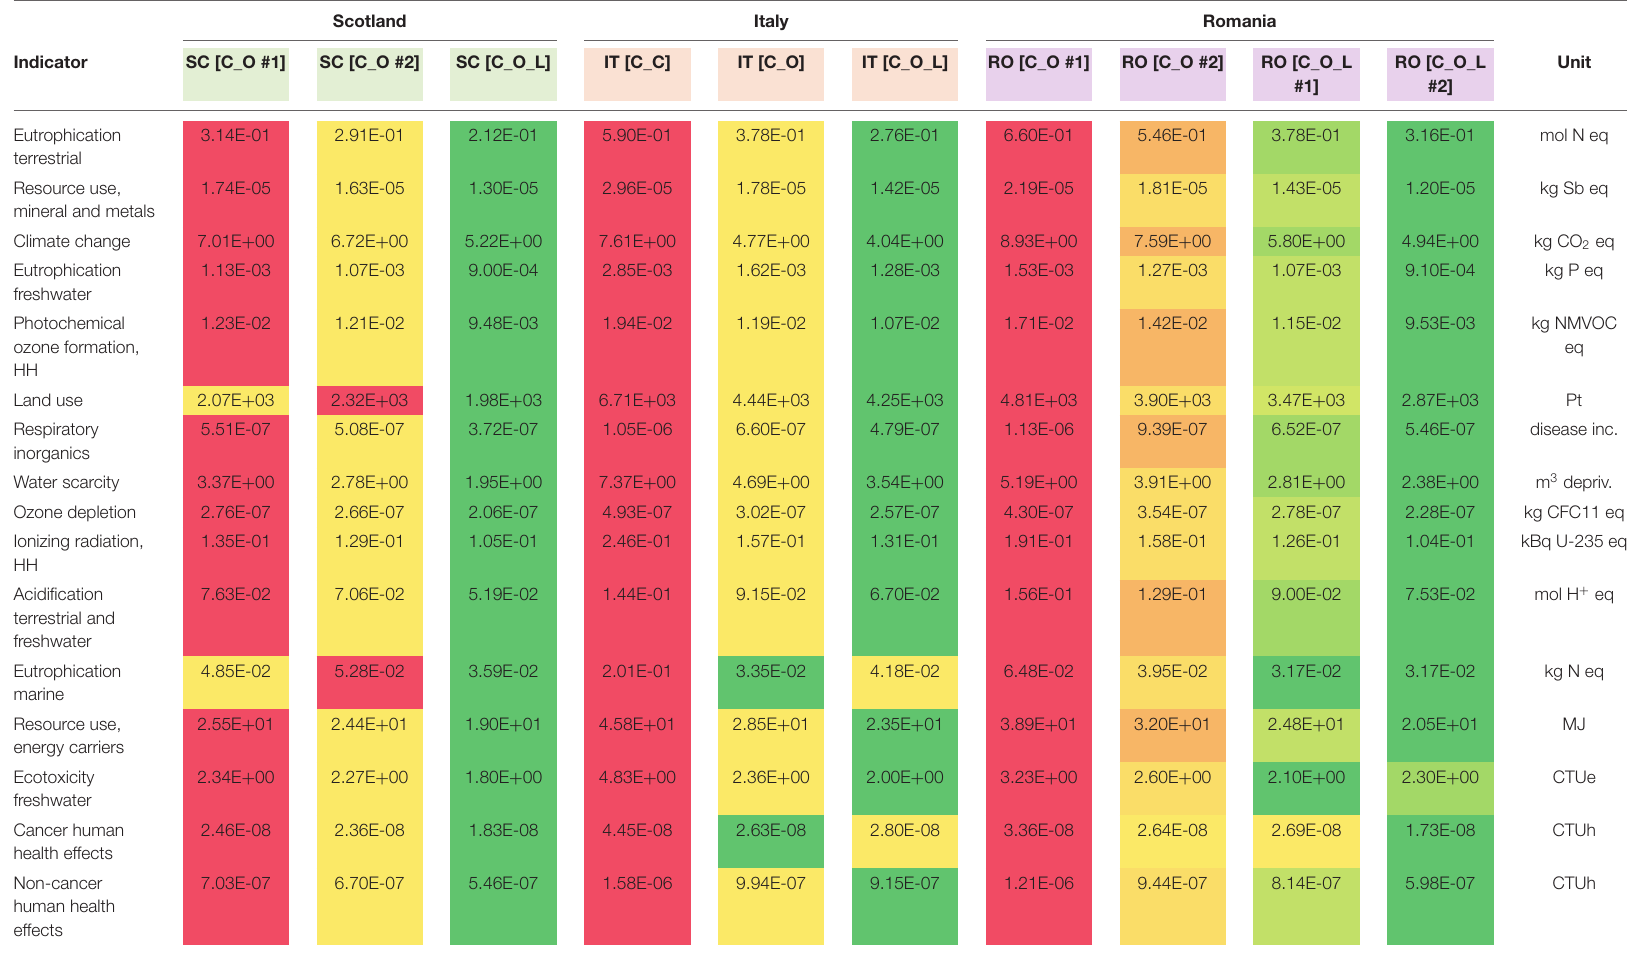
For each impact category and each region, the result for the rotation configuration with the highest impact is shaded darker red and the result for the rotation with the lowest impact is shaded darker